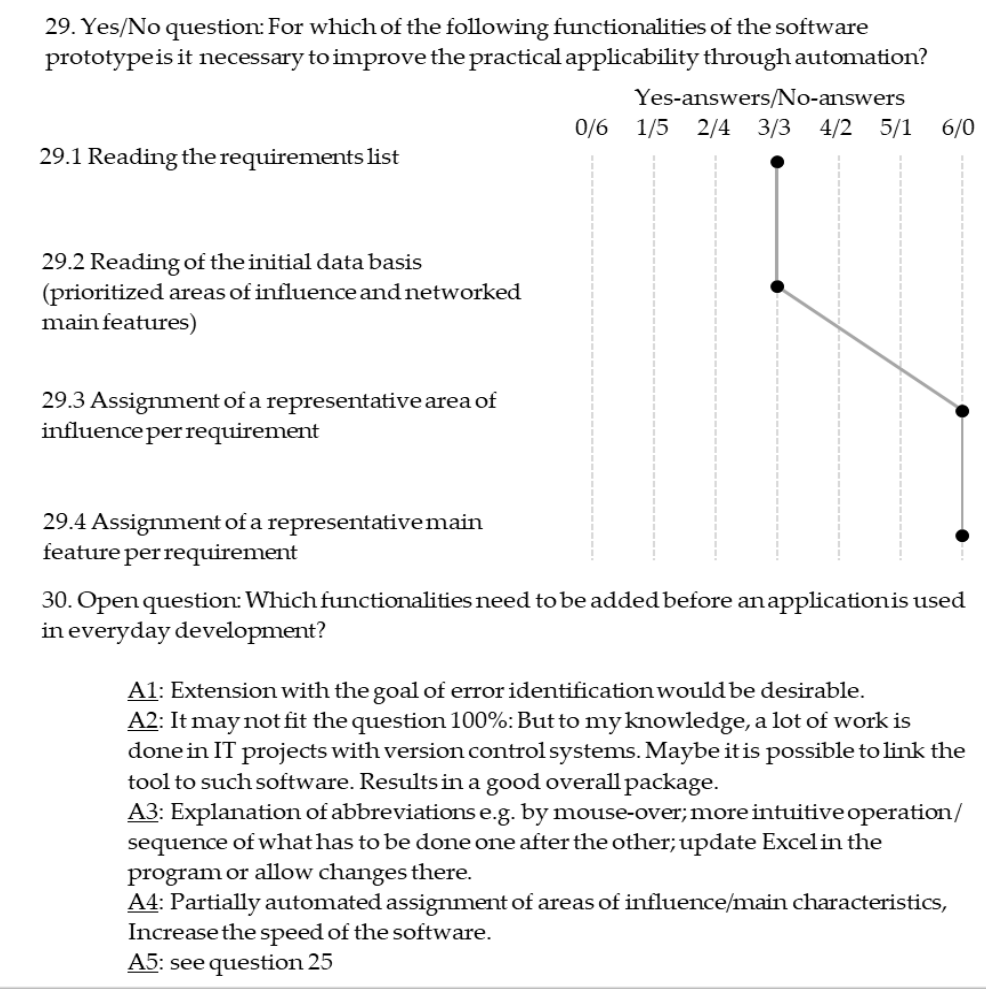
Figure A5. Questionnaire results on area “software prototype” – Part II/II.